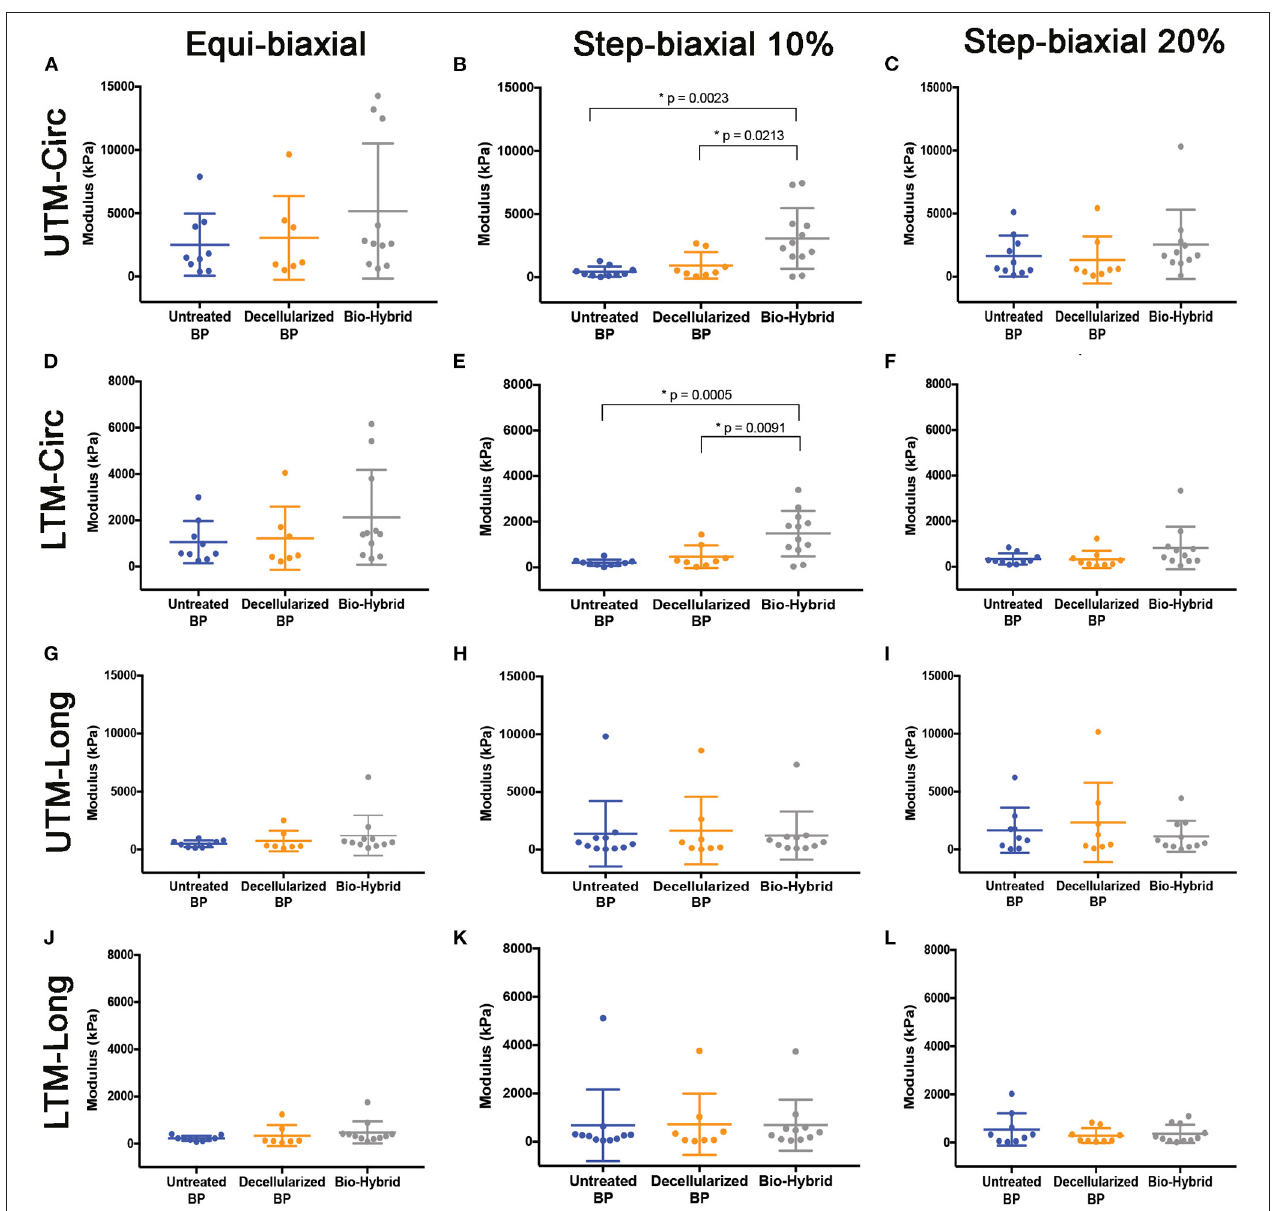
FIGURE 6 | Biaxial upper tangent modulus (UTM) and lower tangent modulus (LTM) of the untreated BP, decellularized BP, and the biohybrid samples from equibiaxial and step biaxial tests. (A–C) UTM in the circumferential direction; (D–F) LTM in the circumferential direction; (G–I) UTM in the longitudinal direction; and (J–L) LTM in the longitudinal direction. Data are represented as mean ± SD. p < 0.05 was considered to be statistically